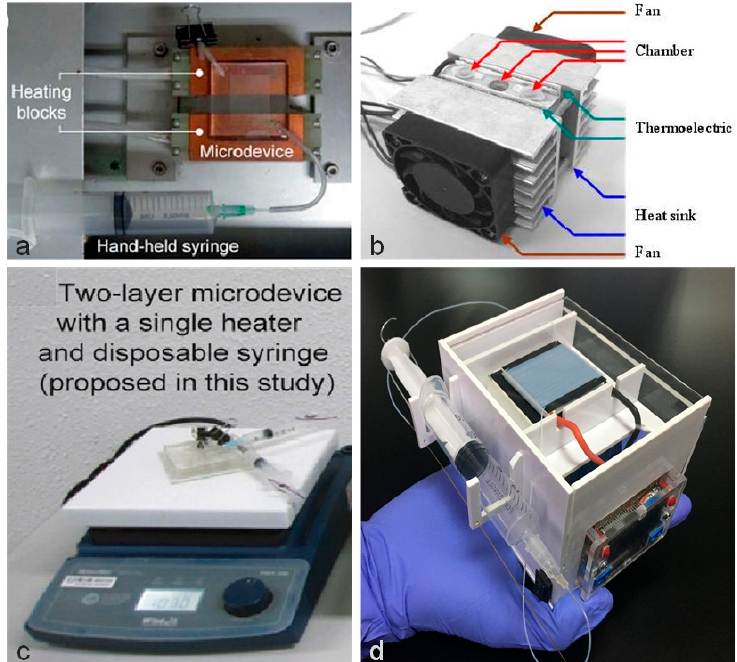
Figure 1. Comparison of the four heating methods. ( a ) By using heating blocks to achieve the required temperature; ( b ) by circuit control to make the thermoelectric cooler (TEC) achieve the required temperature; ( c ) by using a single thermostatic heater to achieve thermal cycling; ( d ) by using a single TEC to achieve thermal cycling of a polymerase chain reaction (PCR) reaction.